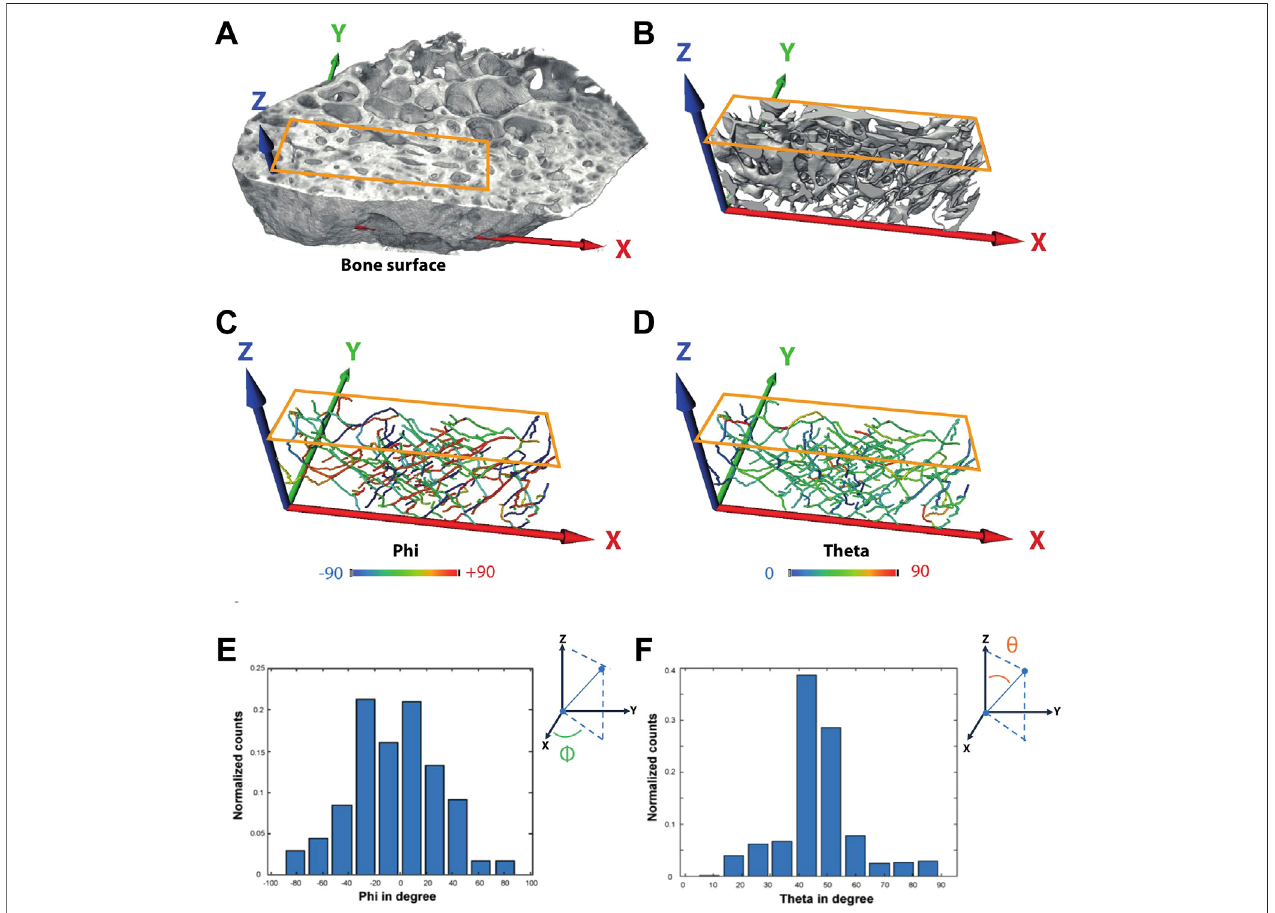
FIGURE2| Exemplaryde fi nitionoftheaxisandcalculationofanglesphiandtheta — SampleP4(IC). (A) Volumerenderingofthefullsampleindicatingtheregionused forfurtheranalysisofthevesselorientation. (B) Surfacerenderingsoftheintracorticalcanalsystem. (C – F) Anglesphiandthetawerecomputedforeachsegmentafterward.